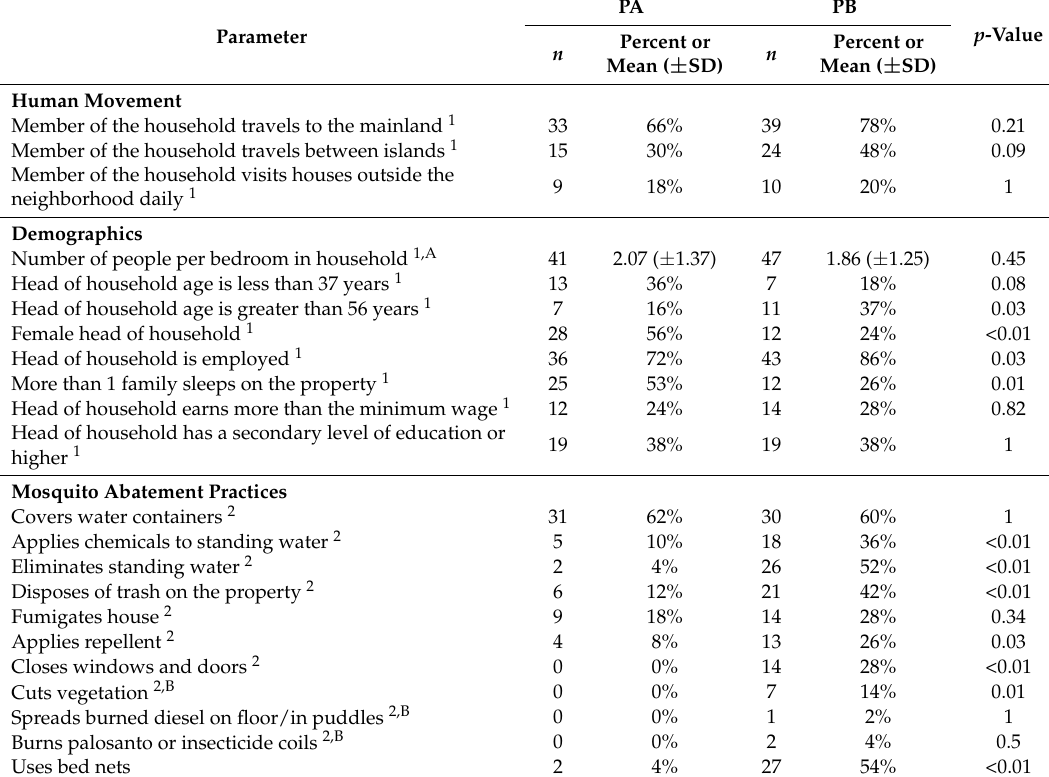
Table 1. Socio-ecological parameters (mean and standard deviation) included in the multi-model selection framework to predict self-reported prior dengue infection and presence/absence of Aedes aegypti adults and/or juveniles at the household level for Puerto Ayora (PA) and Puerto Baquerizo Moreno (PB).